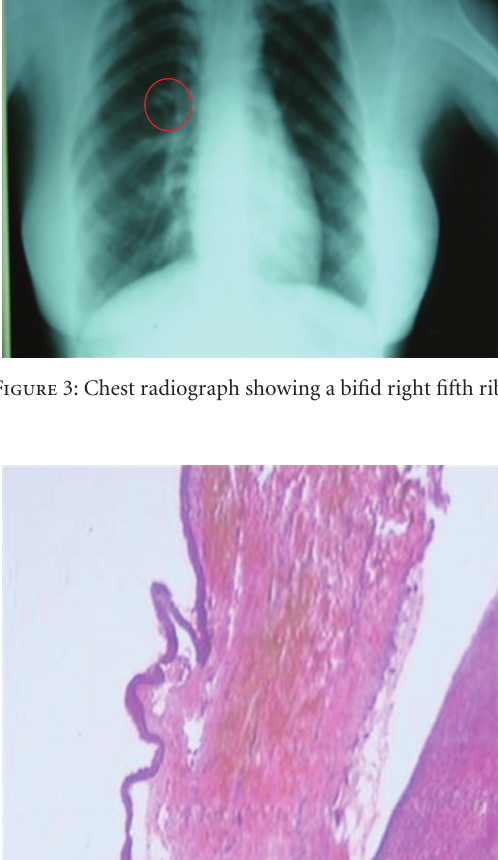
Figure 2: Orthopantomograph showing multiple multilocular well-defined radiolucencies with sclerotic border located in maxilla and mandible.